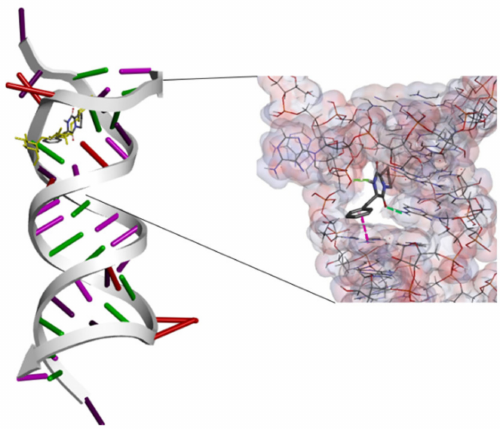
Figure 4. In silico interaction between selected ligand pyrrolo(1,2-F)pyrazine-1,4-d-one,2,3,6,7,8,8A- hexahydro-3-(phenylmethyl) and target RNA fragment (1YRJ). Poses of docked complexes are in the stick model where the x-ray ligand (Paromomycin) in yellow color indicates a prominent active site where the ligand interacted with hydrogen bonding in green and π − π interaction in pink. Non-polar hydrogens are not